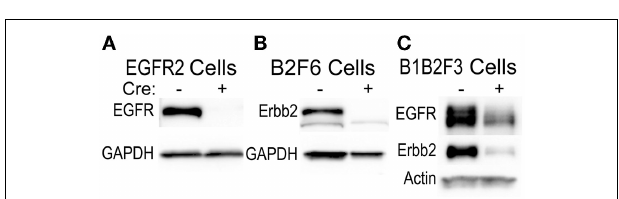
FIGURE 5 | Inducible gene deletion in immortalized cells . The indicated cell lines from Egfr fl/fl FVB/N (EGFR2) (A) , Erbb2 fl/fl FVB/N (B2F6) (B) , or Egfr fl/fl / Erbb2 fl/fl FVB/N mice (B1B2F3) (C) were treated with a control virus or Cre recombinase-expressing adenovirus (Cre + ), protein extracted 24h later, and EGFR and Erbb2 levels assessed using